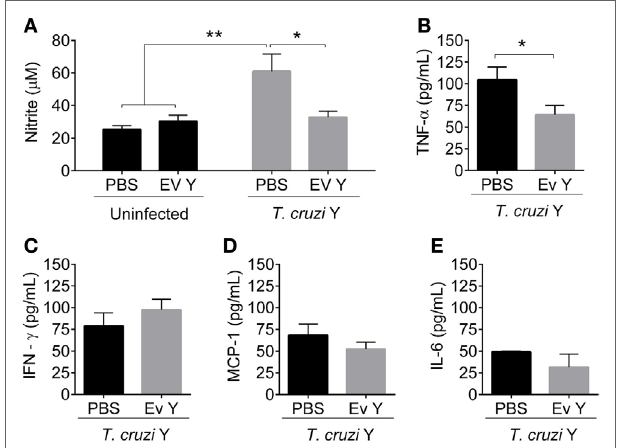
FigUre 2 | Inoculation of Trypanosoma cruzi extracellular vesicles (EVs) prior to infection decreases the plasmatic levels of nitric oxide and TNF- α in infected mice. C57BL/6 mice were inoculated with EVs derived from T. cruzi Y (EV Y) or phosphate-buffered saline (PBS, i.p.). One week later, the mice were infected with T. cruzi by the same route. Uninfected and PBS-inoculated mice were used as controls. Plasma was collected on day 12 after T. cruzi infection. (a) Nitrite in infected and uninfected mice was quantified by the cadmium Griess assay. Cytokines (B) TNF- α , (c) IFN- γ , (D) MCP-1, and (e) IL-6 were quantified by the Cytometric Bead Array. The results are expressed as the mean ± standard error from 5 to 9 mice per group in an experiment representative of two similar experiments. * P < 0.05; ** P < 0.01 significantly different. Two-way ANOVA with (a) Sidak’s post-test and (B–e) Student’s t- test—GraphPad